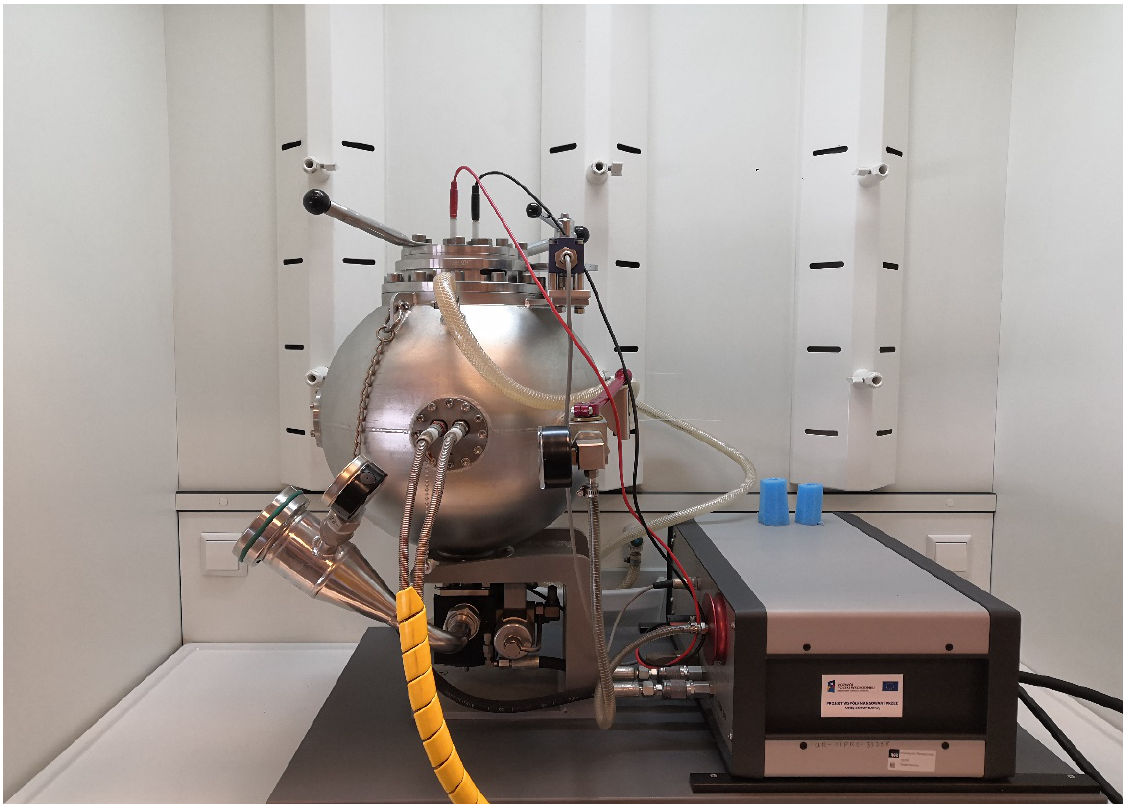
Figure 1. KSEP 310 explosibility analyser.